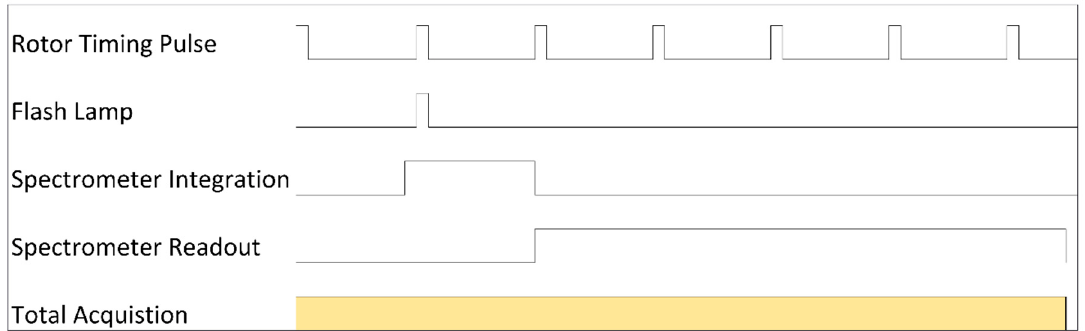
Figure A2. Synchronization timing diagram for a single acquisition in a typical MWL-AUC data collection setup. Note: not drawn to scale.